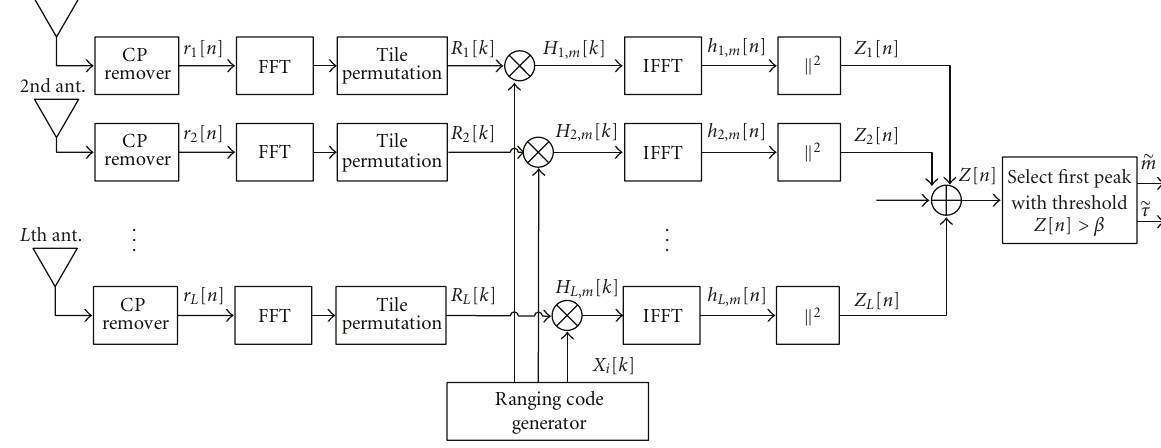
Figure 1: Ranging processing for the m-WiMAX SA system.